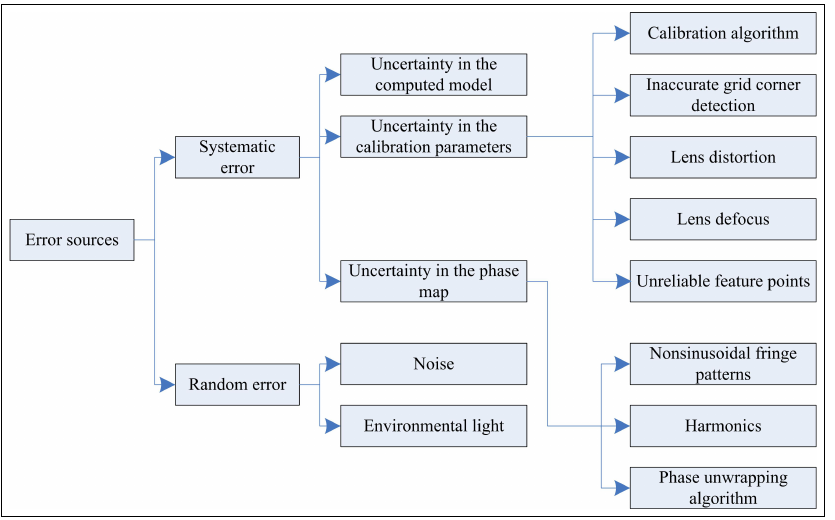
Figure 2. The classification of error